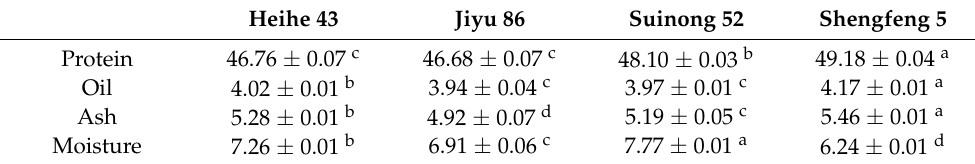
Table 1. The basic components of four kinds of plant-based meat analogues (PBMs) (%).